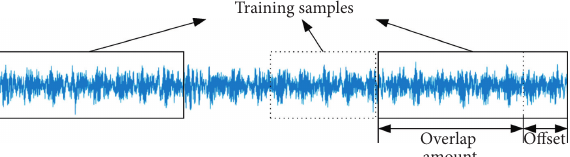
Figure 5: Schematic diagram of overlapping